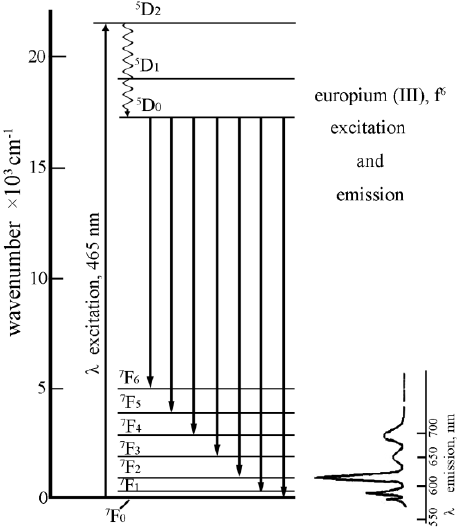
Figure 1. Electronic energy scheme for Eu(III) [15].